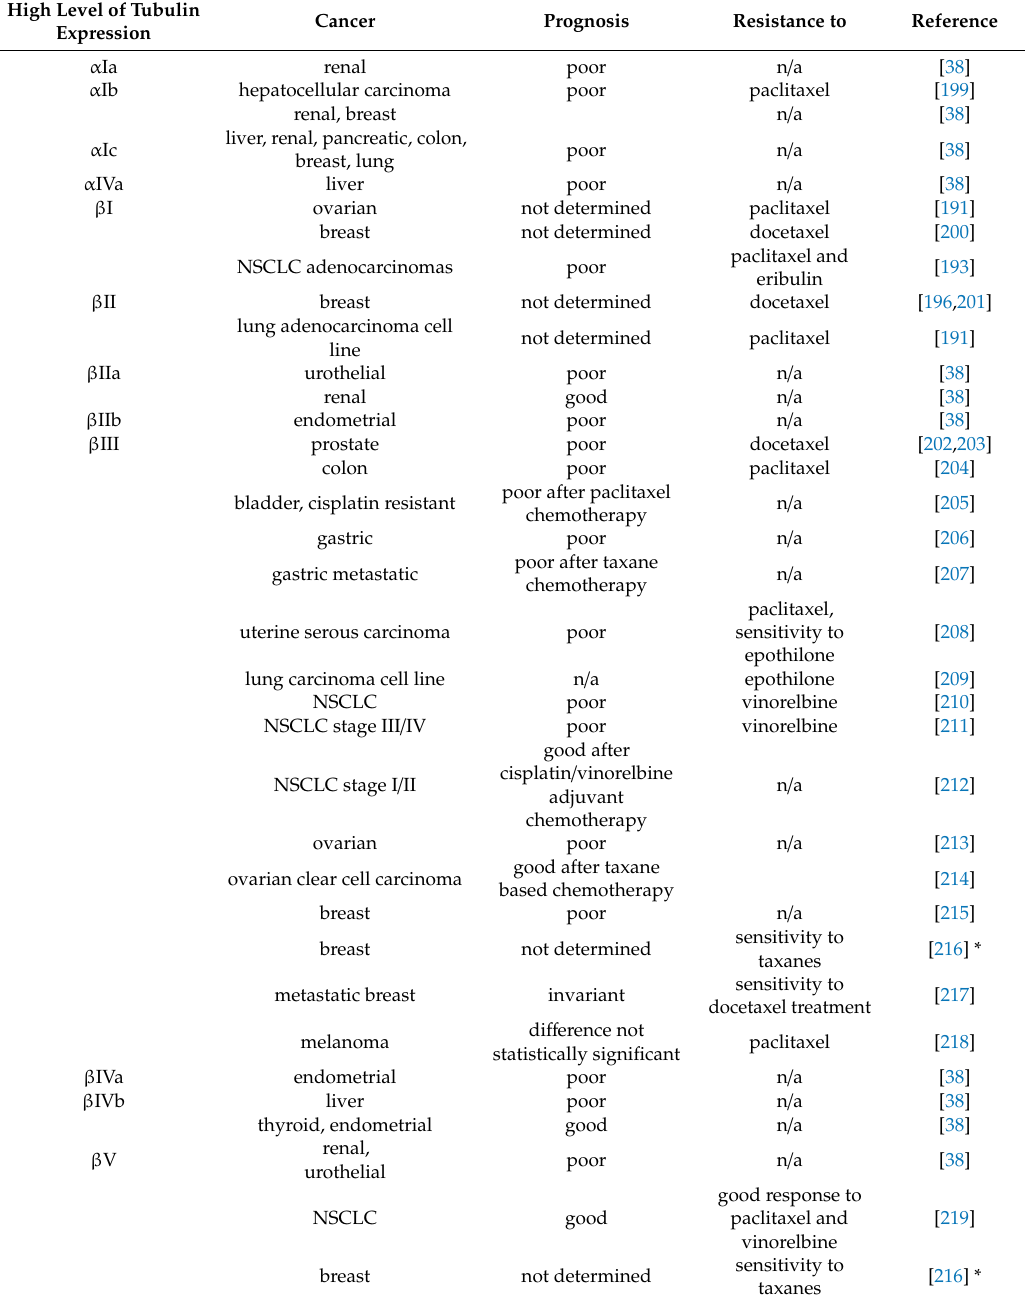
Table 2. Tubulin isotypes as survival and MTA-resistance prognostic markers in cancer. High Level of Tubulin